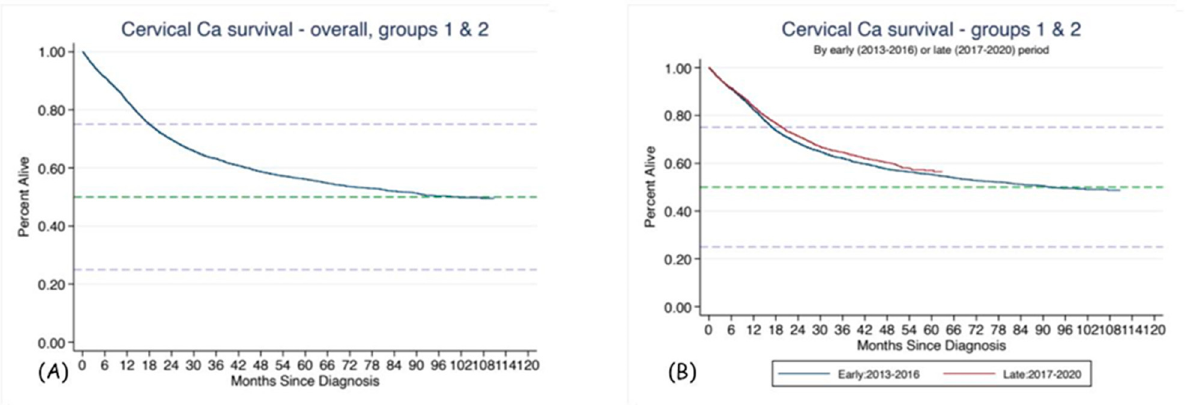
Figure 6. Overall survival of CUC patients from diagnosis: Groups 1 and 2 combined ( A ); according